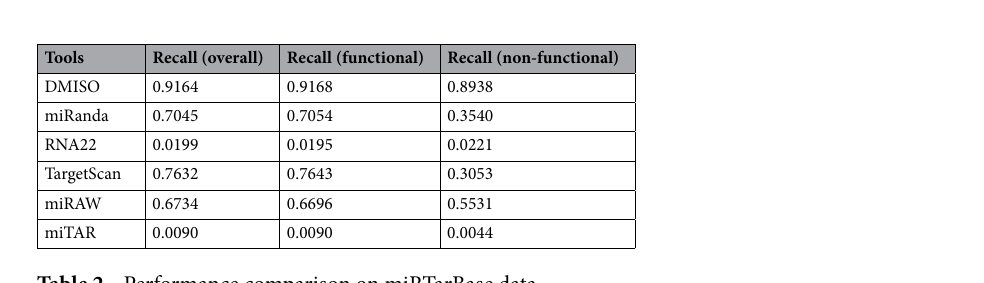
Table 2. Performance comparison on miRTarBase